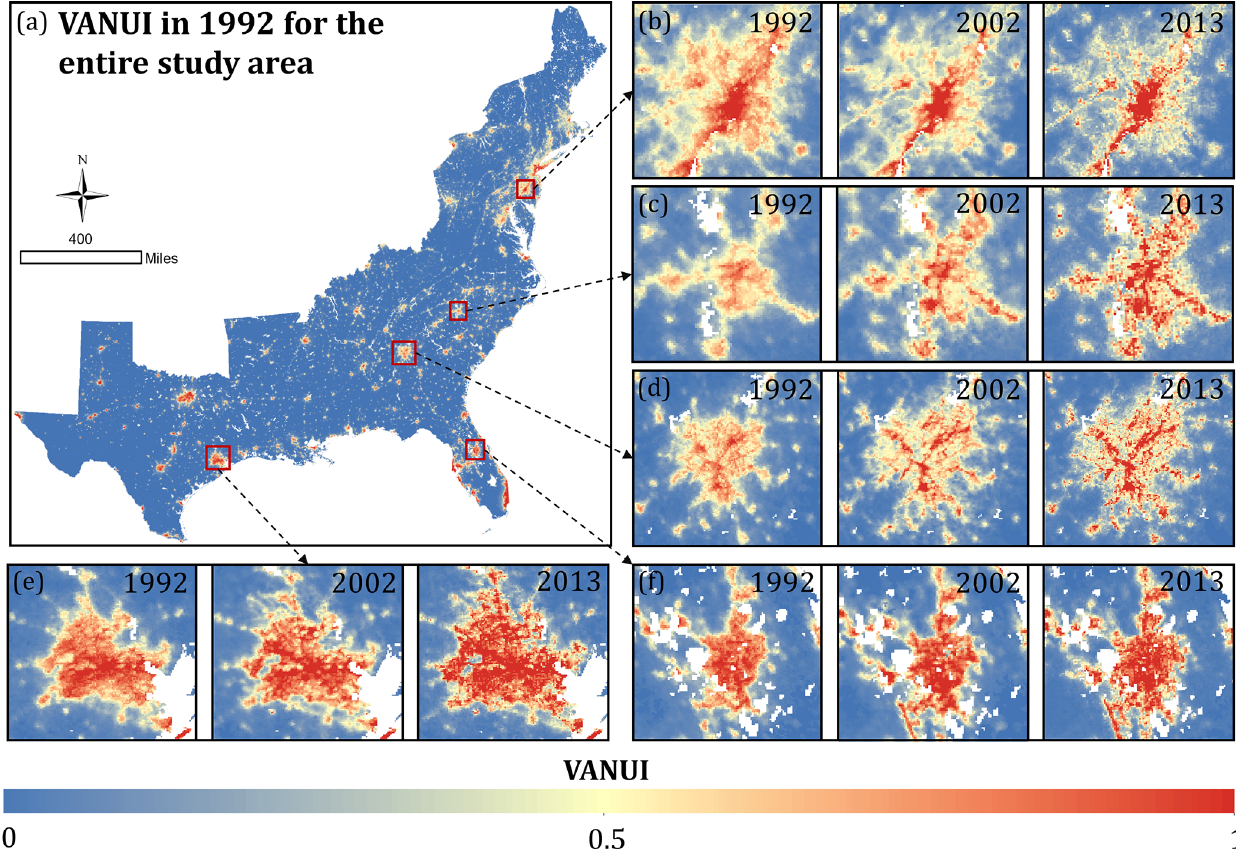
Figure 5. (a) The VANUI distribution in the study area in 1992. The subfigures demonstrate the VANUI variations in 1992, 2002 and 2013 in five selected urban cities: (b) Philadelphia, (c) Charlotte, (d) Atlanta, (e) Houston and (f) Orlando. The white clusters are water bodies masked out of the